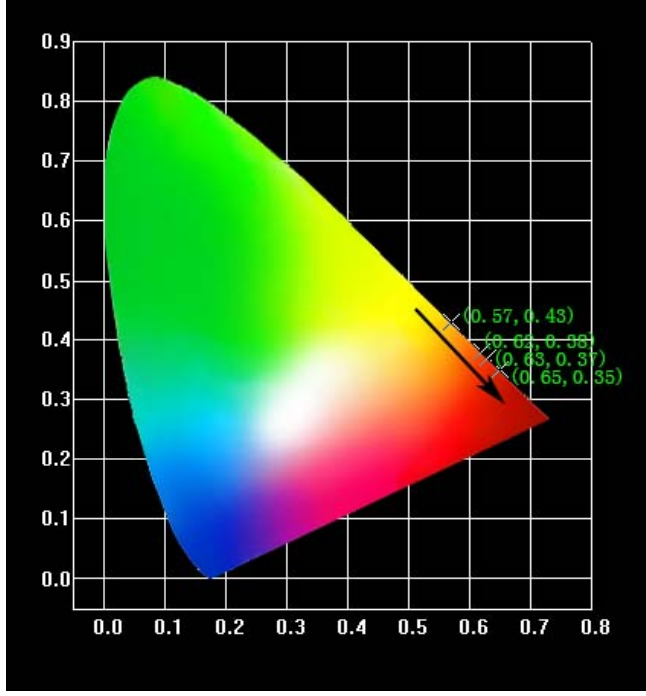
Figure 11. CIE chromaticity diagram of NL 85% − y MO:15%Eu 3+ ,ySm 3+ phosphors excited at 464 nm. Table 2. CIE chromaticity coordinates (x, y) of NL 85% ‐ y MO:15%Eu 3+ ,ySm 3+ (y = 0, 1, 2, 3, 4 and 5%) excited at 464 nm.